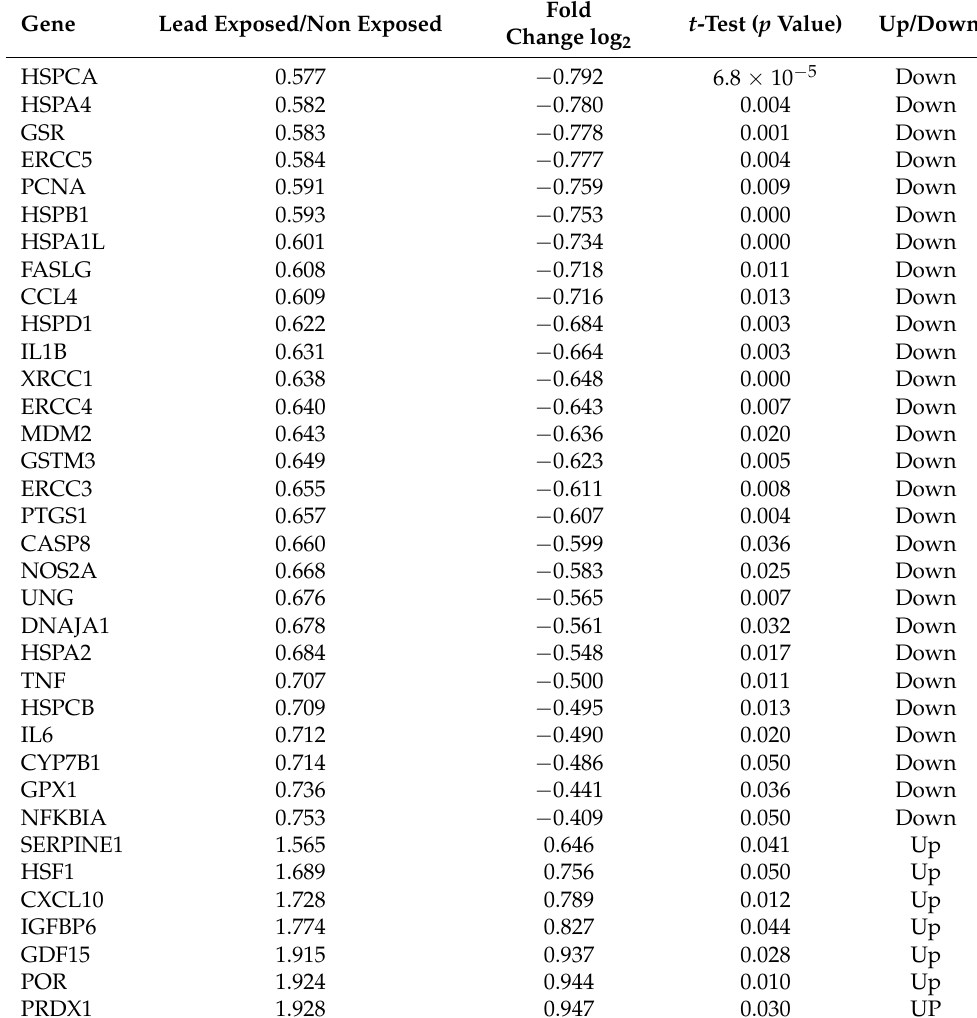
Table 3. Stress and Toxicity genes down or up regulated. Genes that presented a log 2 value greater than − 0.86 with p < 0.05, which is 45 % change, were considered down-regulated genes. While those genes that presented a log 2 value greater than 0.53 with p < 0.5, which also is 45 % of changes, were considered